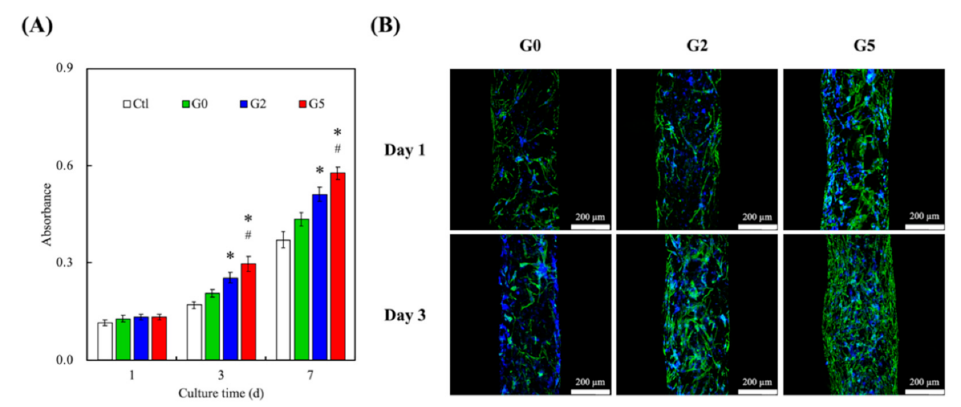
Figure 6. ( A ) Proliferation rate and ( B ) F-actin staining of hDPSCs cultured on the GR-contained MSCS scaffolds for different days. * indicates a significant difference ( p < 0.05) from G0. # indicates a significant difference ( p < 0.05) from G2. Data presented as mean ± SEM, n = 6 for each